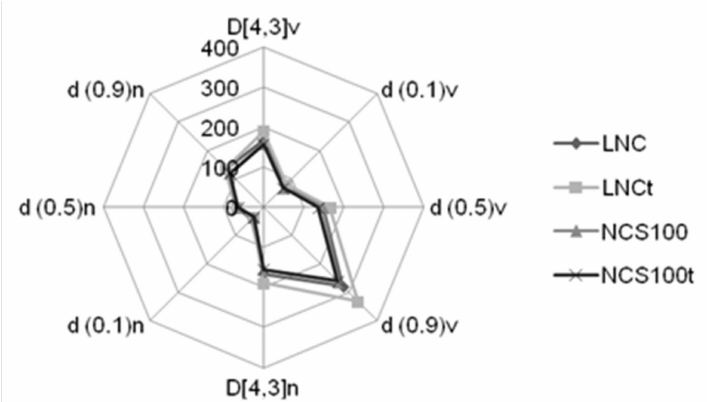
Figure 1. Fingerprint of nanoformulations containing toltrazuril obtained by laser diffraction. The values represent the average for three batches. LNC = blank lipid core nanocapsules; NCS100 = blank Eudragit ® S100 nanocapsules; LNCt = toltrazuril-loaded lipid core nanocapsules; NCS100t = toltrazuril-loaded Eudragit ® S100 nanocapsules formulations; D[4,3]v: volume-weighted mean diameter by volume of particles; d(0.1)v: diameter by volume at percentile 10 under the dis- tribution curve; d(0.5)v: diameter by volume at percentile 50 under the distribution curve; d(0.9)v: diameter by volume at percentile 90 under the distribution curve; D[4,3]n: volume-weighted mean diameter by number of particles; d(0.1)n: diameter by number at percentile 10 under the distribution curve; d(0.5)n: diameter by number at percentile 50 under the distribution curve; d(0.9)n: diameter by number at percentile 90 under the distribution